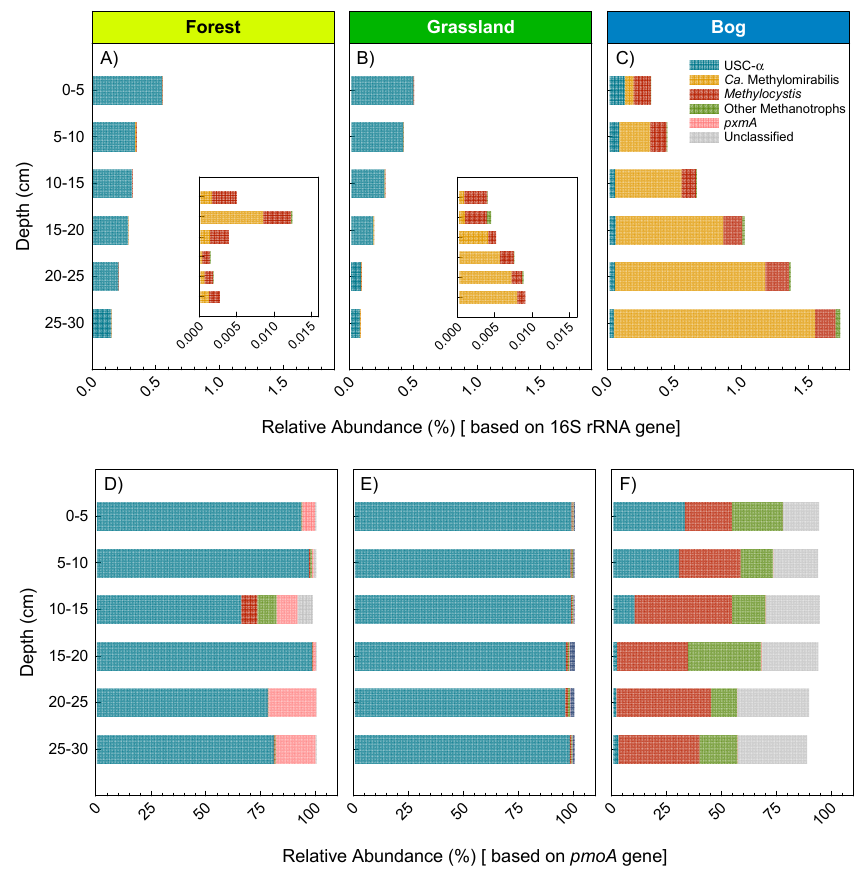
Figure 6. Dominant methanotroph groups detected in the forest ( A , D ), grassland ( B , E ), and bog ( C , F ) soils, based on relative abundance of 16S rRNA and pmoA genes, top and bottom panels, respectively. Inset graphs in A and B show abundance for each corresponding depth but at smaller X -axis scale. USC α was identified by blast as described in the methods. Methylocystis and Ca. Methylomirabilis were identified based on the Silva classifications. Other methanotrophs include Methylomonas and Methylospira . pxmA refer to pmoA -like genes of uncertain function found in the genomes of various methanotrophs.